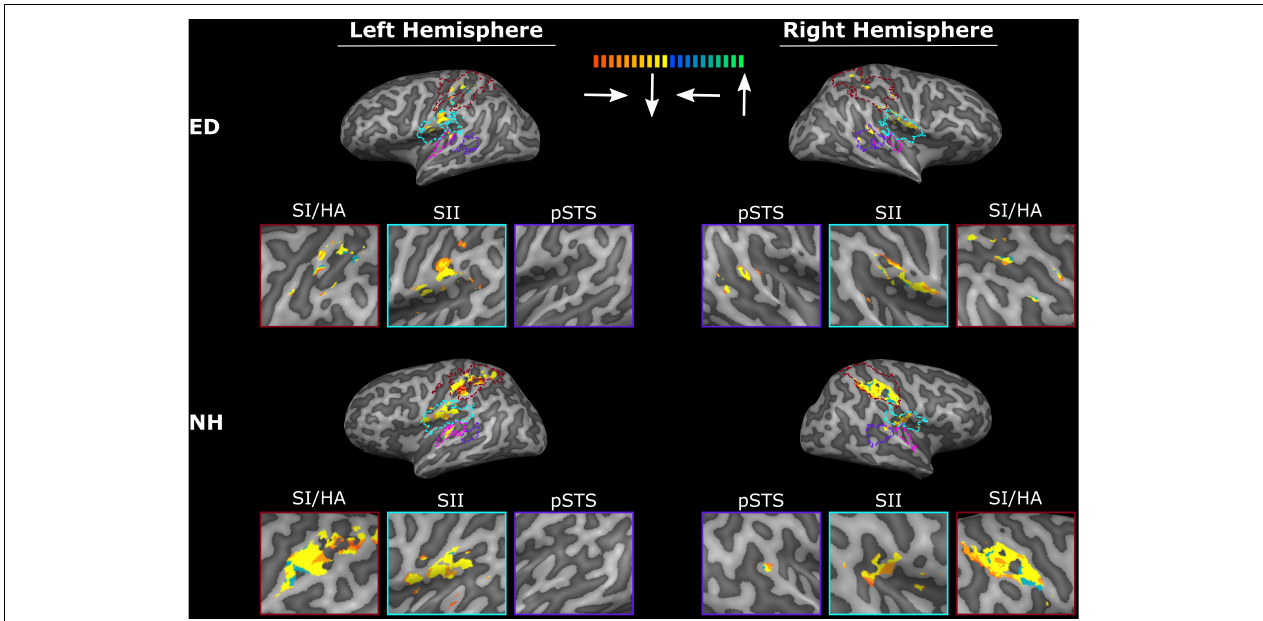
FIGURE 5 | ED and NH participants exhibit similar directional tuning in ipsilateral SI/HA and bilateral SII with minimal tuning in right pSTS region. The best directions within SI/HA (red), SII (blue), functionally defined pSTS region (purple), and PAC (pink) are shown on the cortical surface of a representative ED (top panel) and NH (bottom panel) participant. Direction center values are color-coded along a gradient with right corresponding to red-orange, down corresponding to yellow, left corresponding to blue, and up corresponding to green. All maps are thresholded at r >